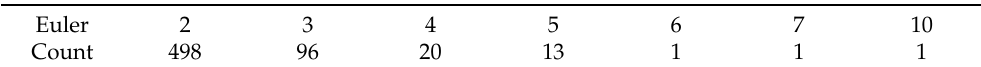
Table 8. Second decomposition type—distribution of combinatorial Euler characteristics of Trian- gle3DNet objects from border interior overlay.